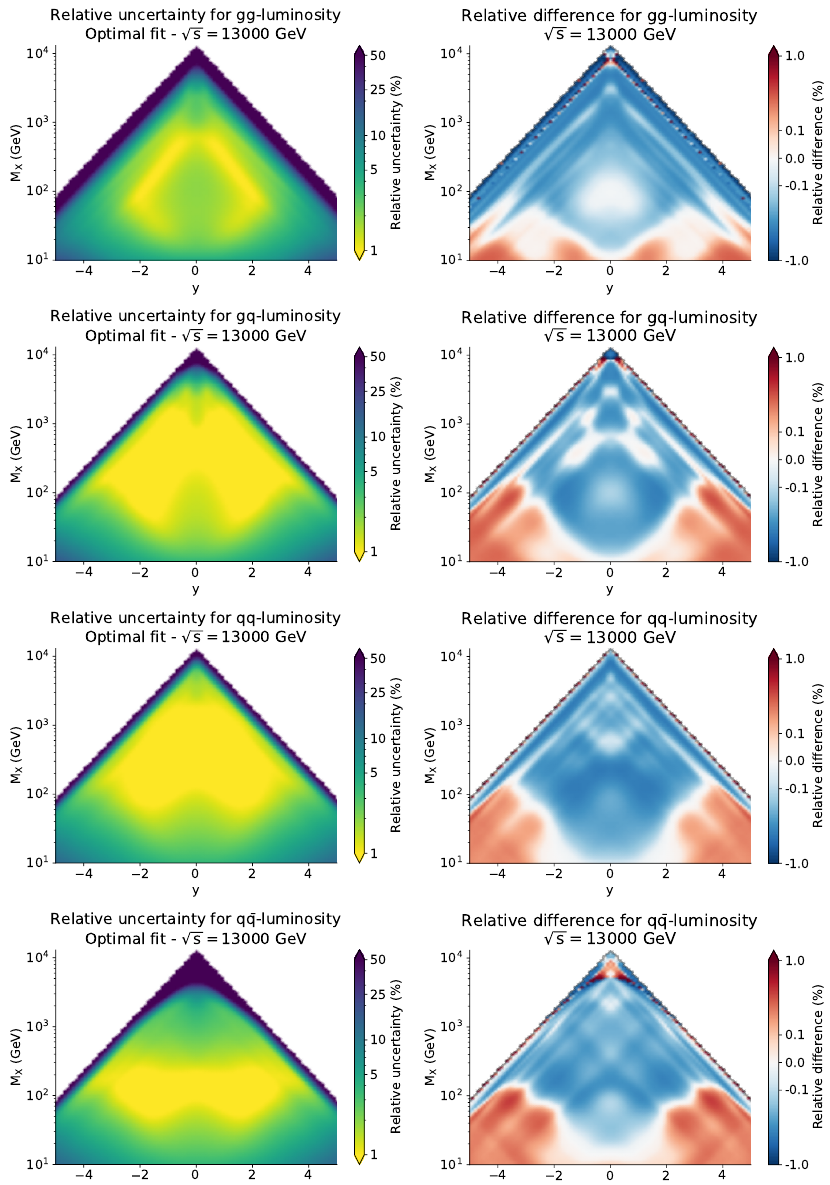
Figure 16 . The parton luminosities as a function of the invariant mass M X and the rapidity y of p the (cid:12)nal state at s = 13 TeV. From top to bottom, the results shown are for the gluon-gluon, gluon-quark, quark-quark, and quark-antiquark luminosities. The results on the left-hand side show the relative uncertainties on the parton luminosities for the Optimal (cid:12)t. For these plots the colour bars indicate the relative uncertainty, with yellow representing uncertainties of around 1%. The results on the right-hand side show the relative di(cid:11)erence in uncertainties between the Baseline Fit (Fit 1) and the Optimal (cid:12)t. The relative di(cid:11)erence is found by taking the uncertainty for the Baseline (cid:12)t away from the uncertainty for the Optimal (cid:12)t, and normalising to the former. Therefore, relative decreases in the uncertainty are shown in blue and relative increases are shown in red.